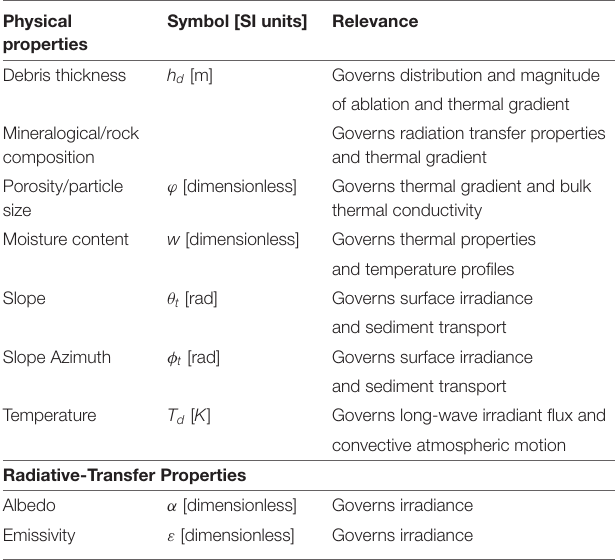
TABLE 1 | Debris-cover physical and radiative-transfer properties that regulate ablation in space and